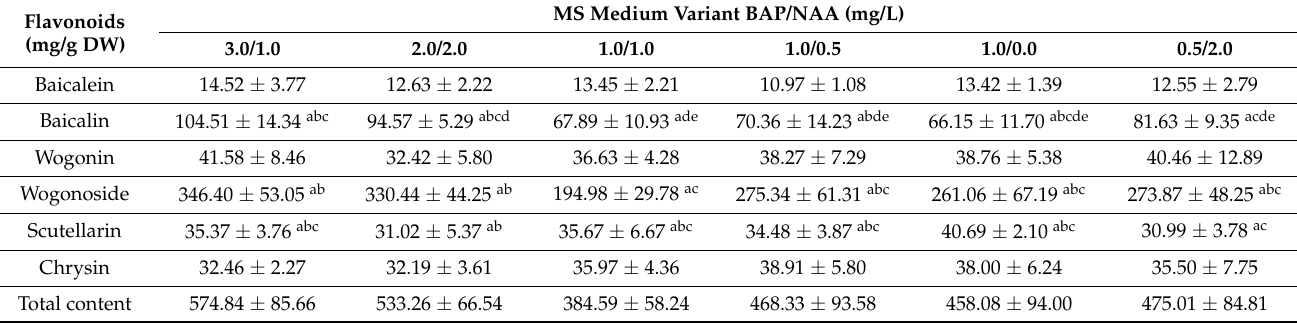
Table 2. Flavonoid content in biomass extracts of Scutellaria brevibracteata subsp. subvelutina in vitro cultures (MS medium variants with BAP and NAA; 4-week growth